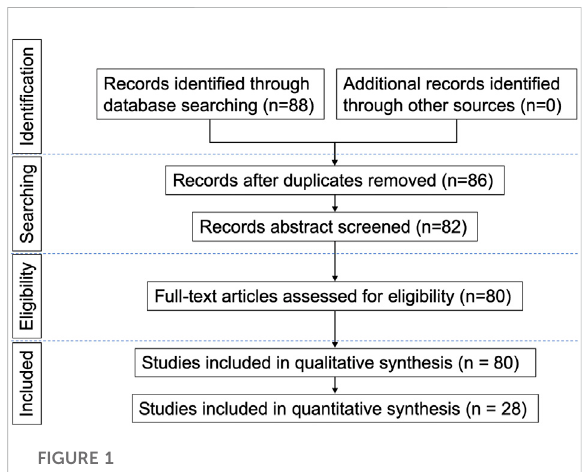
FIGURE 1 Flow chart illustrating the selection and inclusion